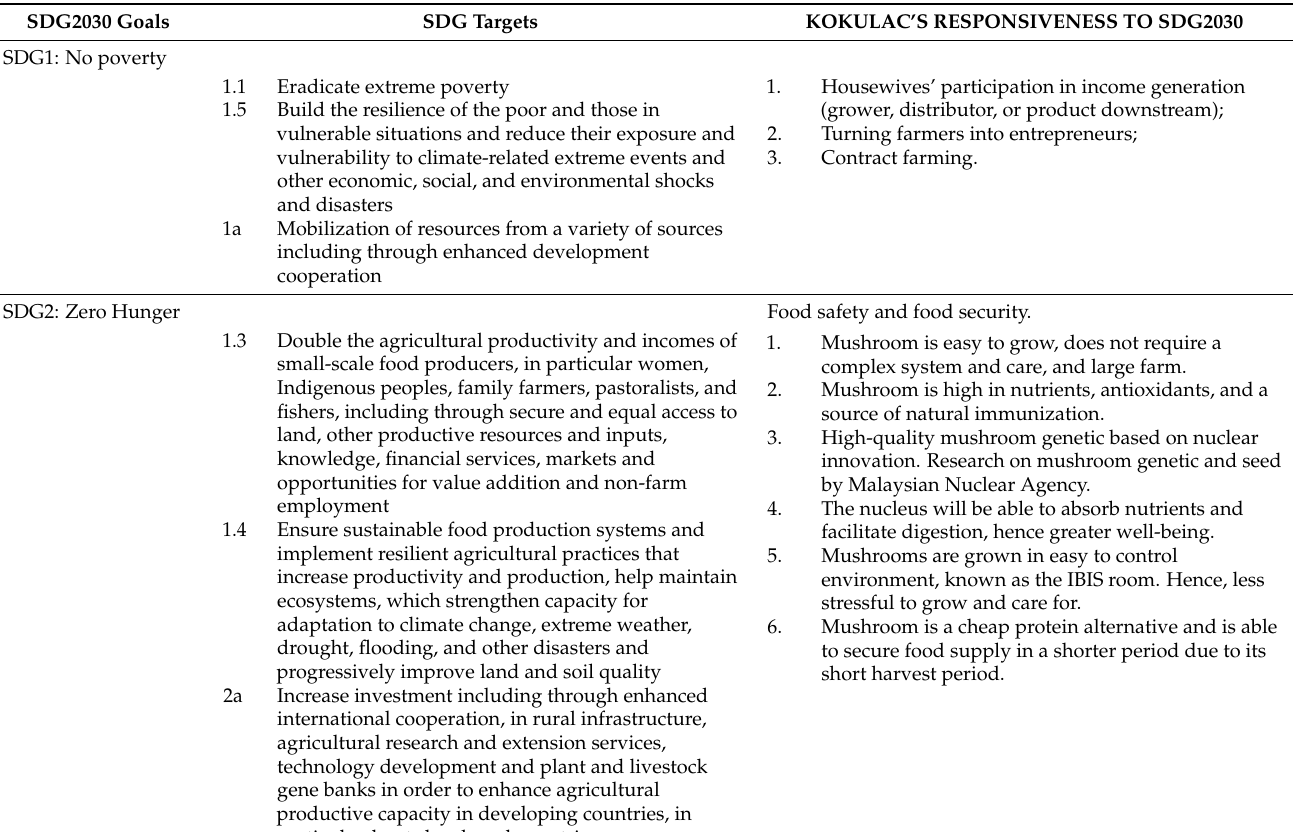
Table 3. The KOKULAC and Sustainability